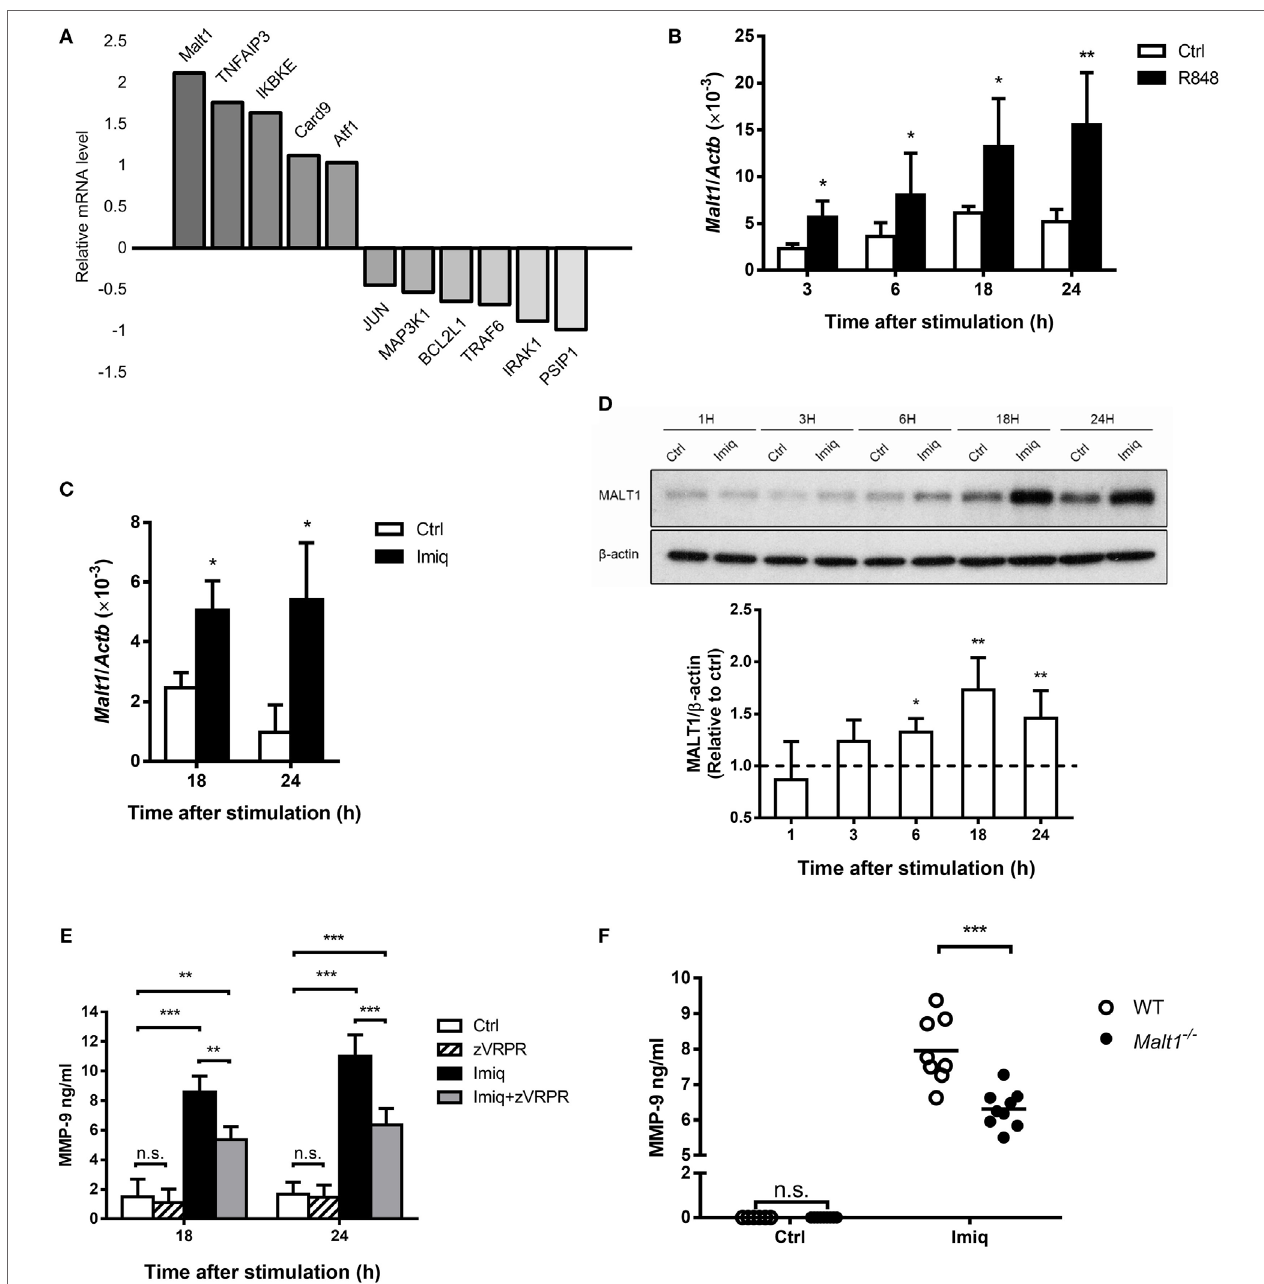
FigUre 2 | Toll-like receptor 7-mediated mucosa-associated lymphoid tissue lymphoma translocation protein 1 (MALT1) upregulation is required for matrix metalloproteinase-9 (MMP-9) production in alveolar macrophages. (a) MH-S cells were stimulated with or without R848 (10 µM). RNA was extracted at 24 h after stimulation and applied to microarray chip. Relative levels of mRNA expression were compared to unstimulated cells. Data were compiled from one experiment. (B,c) MH-S cells were stimulated with or without (B) R848 (10 µM) and (c) imiquimod (Imiq, 1 µg/ml). The level of Malt1 mRNA was quantified by qPCR and normalized against Actb at indicated time points ( n = 4, four independent experiments). (D) MH-S cells were stimulated with or without Imiq (1 µg/ml) for indicated periods of time. Cell lysates were analyzed for MALT1 and β -actin protein by Western blotting. Bar graphs show the levels of MALT1 protein normalized against β -actin ( n = 4, four independent experiments. One representative experiment is shown). The MALT1-to- β -actin ratio at each time point without stimulation (Ctrl) was taken as 1.0. (e) MH-S cells were pretreated with z-VRPR-fmk (zVRPR, MALT1 inhibitor, 100 µM) for 6 h before stimulation with or without Imiq (1 µg/ml) for another 18 and 24 h. MMP-9 concentration was quantified by ELISA ( n = 3, three independent experiments). (F) Primary alveolar macrophages from wild-type and MALT1-deficient mice were stimulated with or without Imiq (1 µg/ml) for 48 h. The concentration of MMP-9 in culture supernatants was quantified by ELISA. Each dot represents cells from one mouse and data are a compilation of three independent experiments. n.s., not significant, * p < 0.05, ** p < 0.01, and *** p < 0.001 compared to control. (B–D) were analyzed by Mann–Whitney U -test, and (e,F) were analyzed by one-way ANOVA followed by (e) Tukey’s and (F) Sidak’s post hoc